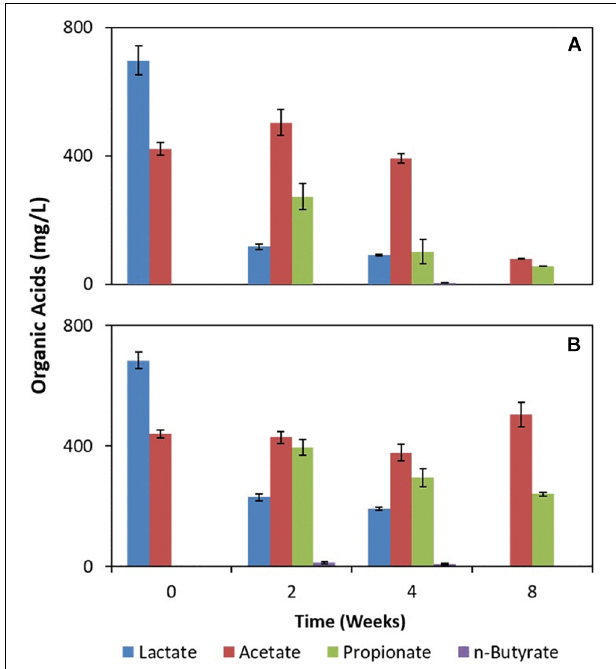
FIGURE 4 | Measurements of organic acids in pumice slurries amended with electron donors and incubated at 20 ◦ C over the period of 8 weeks. (A) Fe(III)-coated sample deployed and amended with lactate and acetate. (B) Uncoated pumice sample deployed and amended with lactate and acetate. The data are the means ± standard errors of